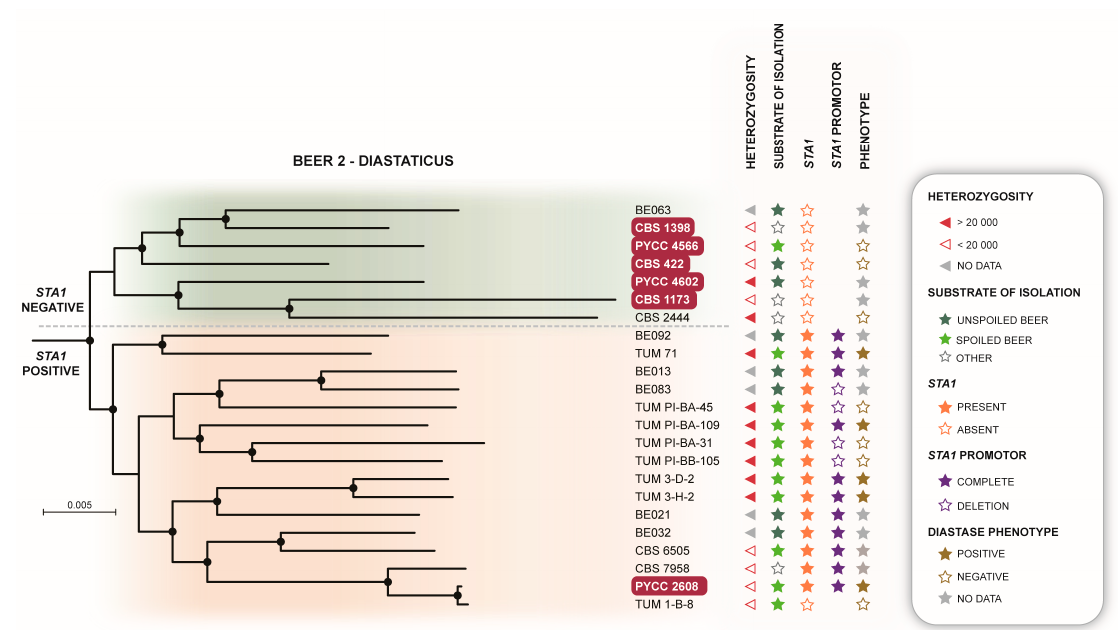
Figure 2. The Beer 2-Diastaticus clade of S. cerevisiae contains STA1 -positive and STA1 -negative strains. Detail of the main phylogeny showing the phylogenetic relationships within the Beer 2-Diastaticus clade together with relevant genetic and phenotypic